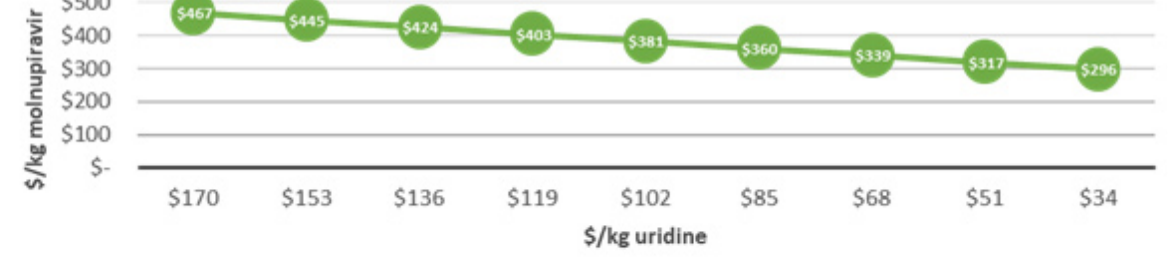
Figure 2. M4ALL Improved Uridine Route sensitivity analysis for Uridine.